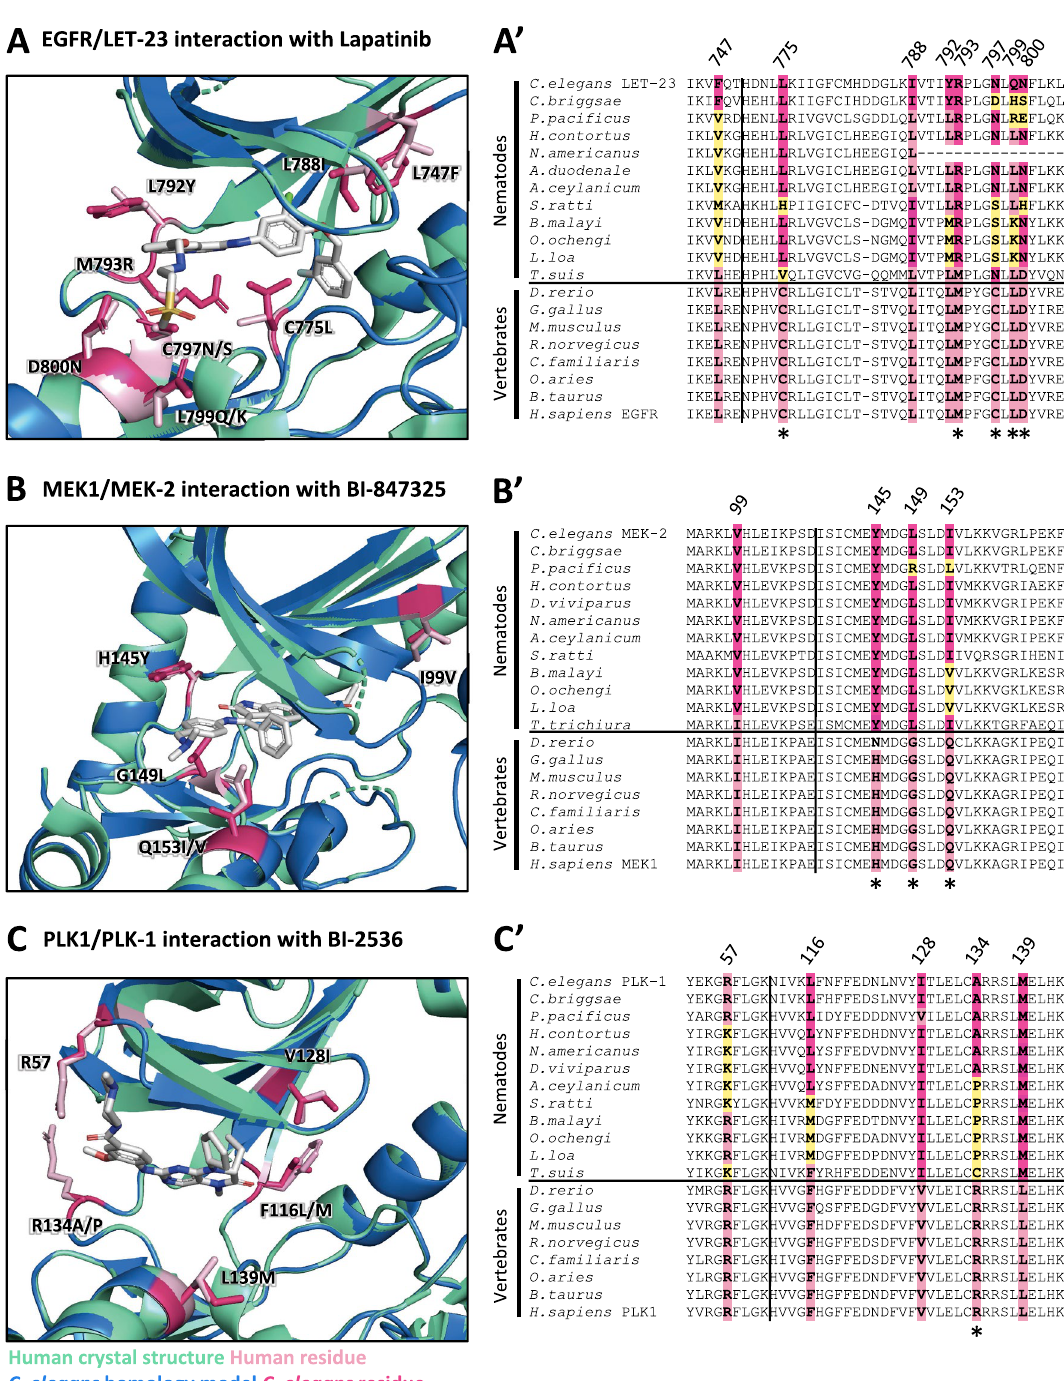
Figure 2. Structure analysis identifies LET-23, MEK-2 and PLK-1 as candidate targets for anthelmintic development. C. elegans homology models (blue) for LET-23, MEK-2 and PLK-1 aligned with human crystal structure (green) for EGFR (PDB: 1XKK) 86 , MEK1 (PDB: 5EYM) 59 and PLK1 (PDB: 2RKU) 64 are shown in ( A – C ) respectively. Key divergent residues proximal to the inhibitor binding sites are highlighted in dark pink ( C. elegans residue) and light pink (human residue) within the structure diagrams ( A – C ). Residues are labeled according to their position in the human kinase, with the first letter indicating the identity of the vertebrate residue and the latter indicating the identity of the nematode residue(s). The conservation of these residues among free-living nematodes, parasitic nematodes and vertebrates is displayed in the corresponding sequence alignments ( A ′ – C ′ ). The vertical line indicates a discontinuous break in the sequence. The horizontal line indicates the separation between the nematode and vertebrate sequences. Yellow residues in the sequence alignments highlight those nematode residues that differ in identity from both vertebrate and C. elegans sequence at the location of these divergent residues of interest. Residues that have distinct physicochemical properties between vertebrates and nematodes are indicated with an asterisk below the